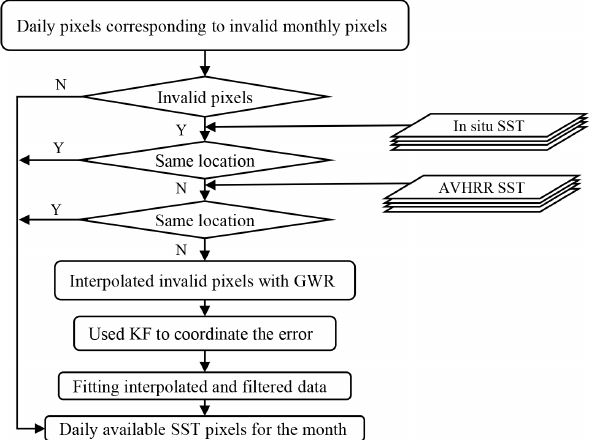
Figure 8. A summary flow chart for reconstructing invalid SST pix- els in low-latitude and midlatitude marginal regions of the